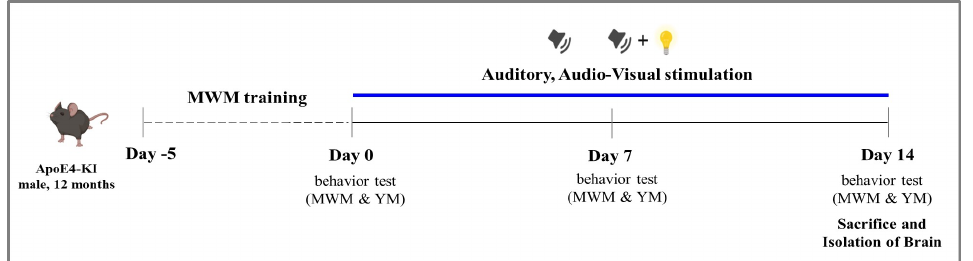
Figure 6. Experimental timelines. After 5 days of training in the MWM, ApoE4-KI mice received auditory and audiovisual stimulation for 14 days (no stimulation, n = 5; auditory stimulation, n = 10; audiovisual stimulation, n = 10). Behavior tests consisting of the MWM and YM were performed before (day 0) and after (day 7, day 14) auditory and audiovisual stimulation. The mice were eu- thanized 14 days after sensory stimulation. Their brain tissues were then analyzed for histopatho- logical changes. ApoE4-KI, Apoe tm1.1(APOE*4)Adiu j; MYM, Morris water maze; YM, Y maze. histopathological changes. ApoE4-KI, Apoe tm1.1(APOE*4)Adiuj ; MYM, Morris water maze; YM, Y